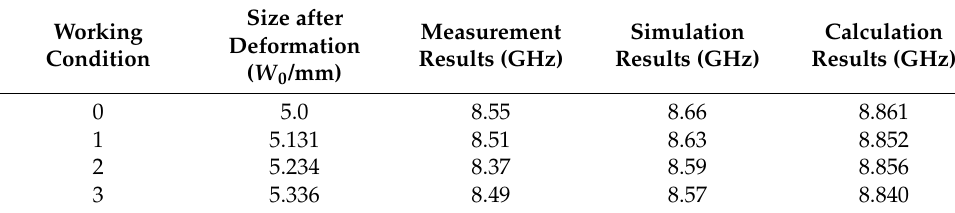
Table 15. Resonant frequencies of the Mode 2 antenna under four working